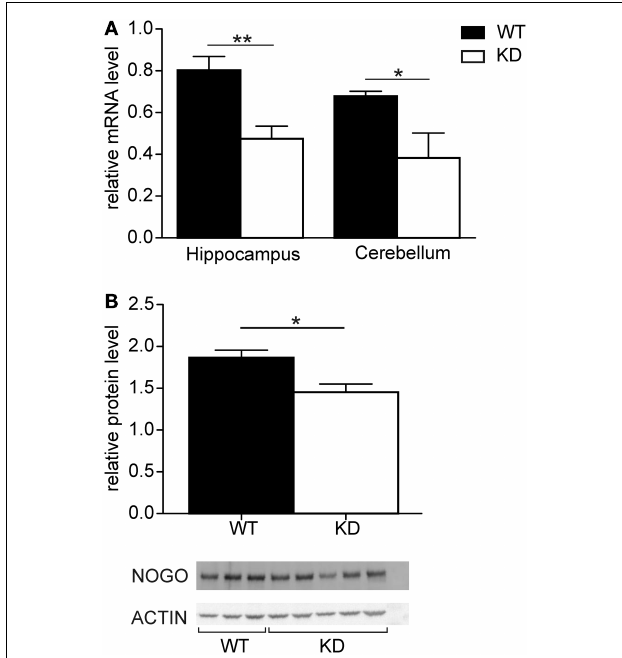
FIGURE 1 | Nogo-A mRNA and protein expression in Nogo-A knockdown rats (designated KD) and wild-type (WT) controls . (A) Relative levels of Nogo-A mRNA in the hippocampus ( n = 14 forWT, n = 10 for KD) and cerebellum ( n = 7 forWT, n = 5 for KD) of wild-type (black) and knockdown (white) animals. (B) Relative levels of Nogo-A protein in the hippocampus of wild-type (black) and knockdown (white) animals.The graph shows mean optical density of Nogo-A normalized to actin of threeWT and five KD